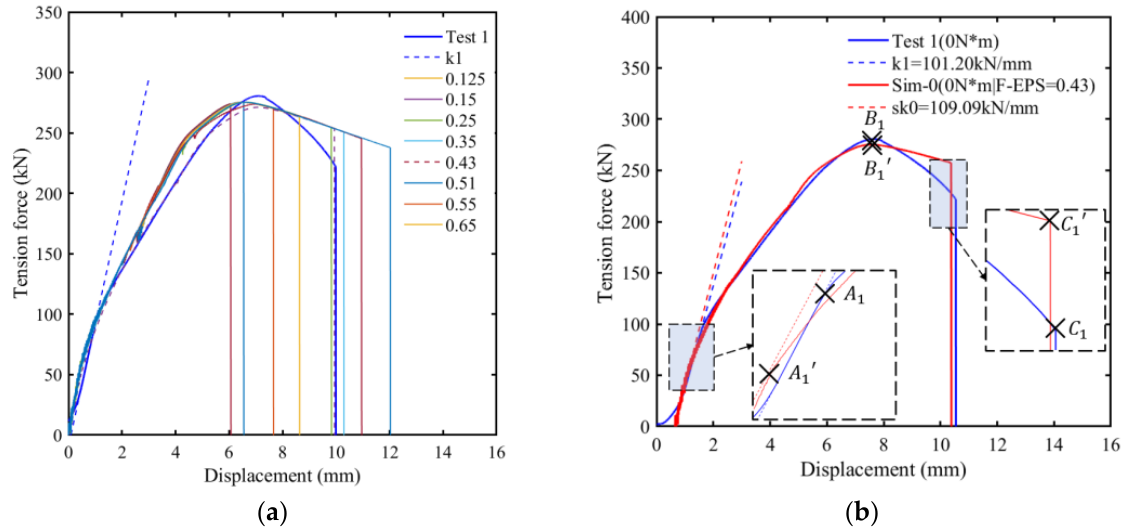
Table 6. Relative errors (%) of data characteristics in Test 1 and FEM-0. Type